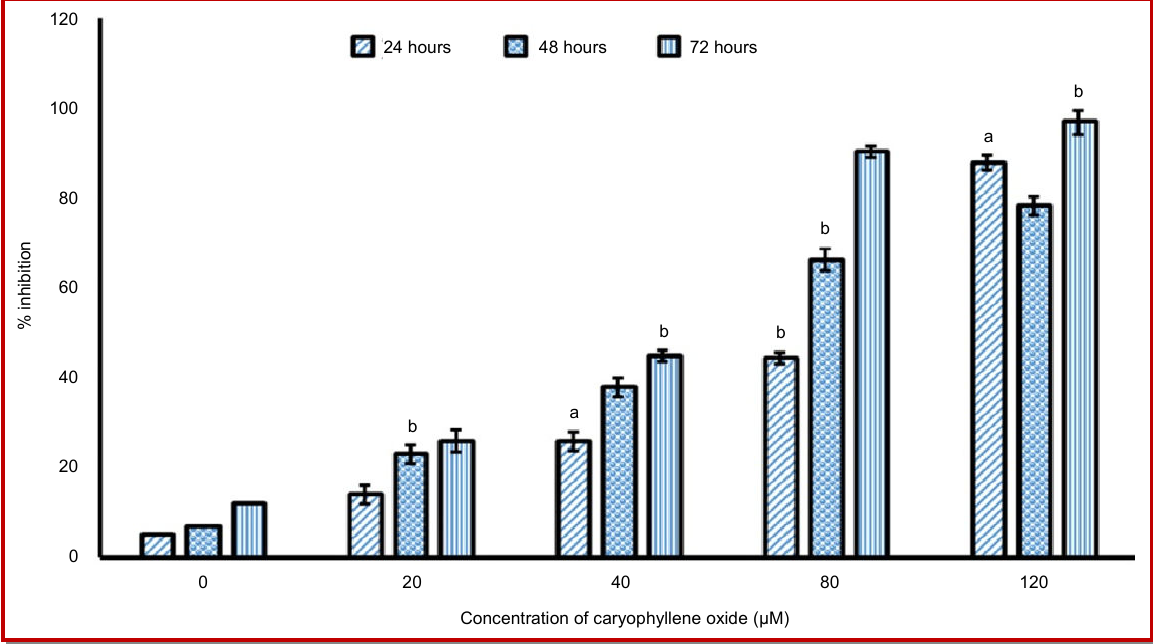
Figure 1: Cytotoxic effect of caryophyllene oxide in human osteosarcoma cells (MG-63) at different doses. Data are shown as the mean ± SD of three independent experiments. a p<0.05, b p<0.01, vs 0 µM